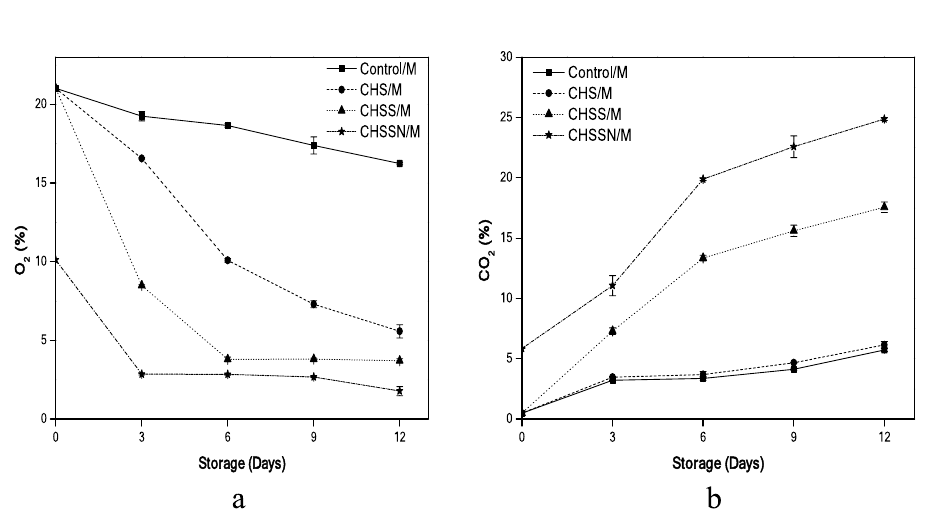
Figure 3. Effects of nano-coating treatments on headspace gas composition O 2 ( a ) and CO 2 ( b ).